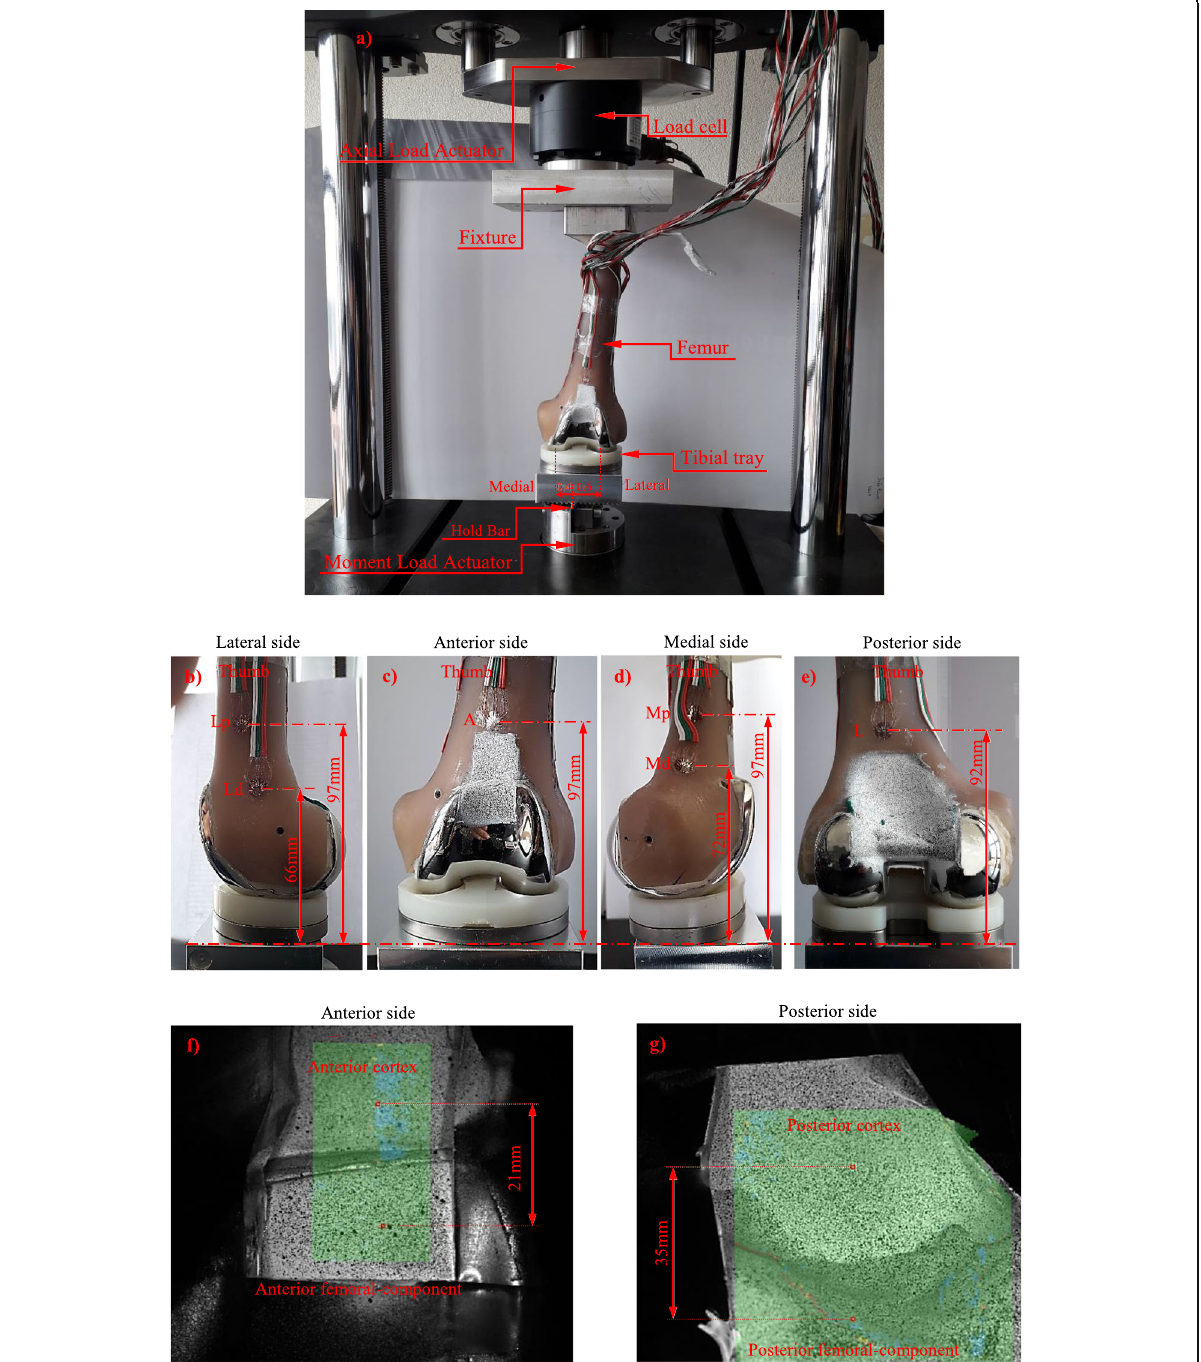
Fig. 2 a Loading machine and experimental setup; b Strain gauges locations at Lateral side Lp (lateral proximal) and Ld (lateral distal); c Strain gauge location at Anterior side (A); d Strain gauges locations at Medial side Mp (medial proximal) and Md (medial distal); e Strain gauge location at Posterior side (P); f DIC image - stochastic pattern at Anterior femur side; g) DIC image - stochastic pattern at Posterior femur